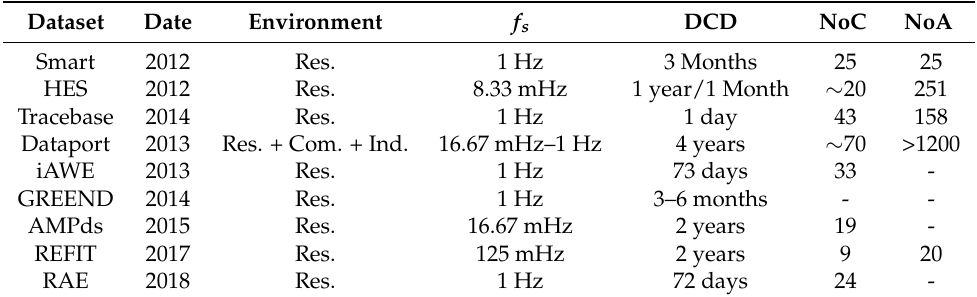
Table 2. Comparison between low-frequency Non-Intrusive Load Monitoring (NILM)